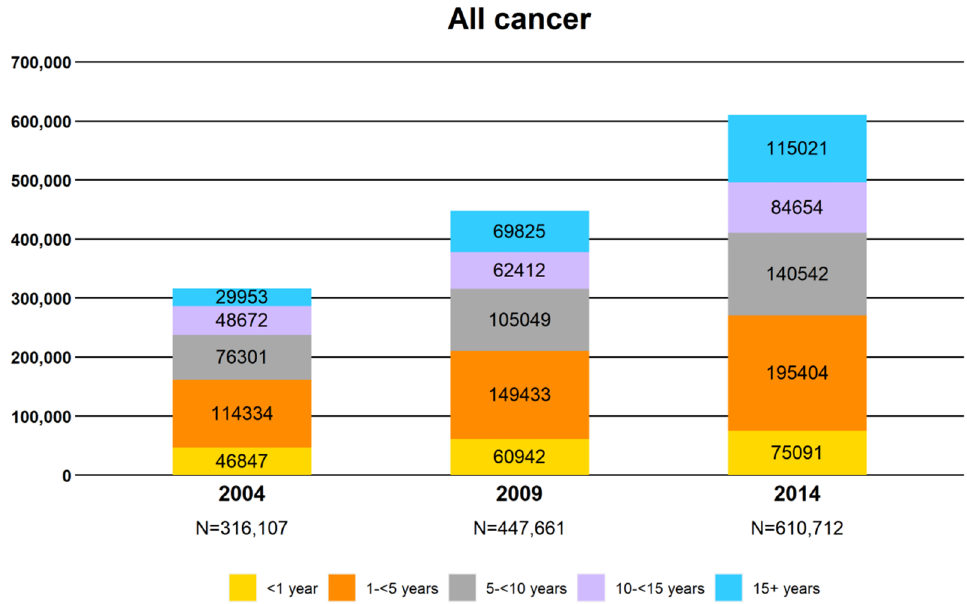
Figure 3. Prevalence of cancer survivors by calendar year and number of years from diagnosis: All